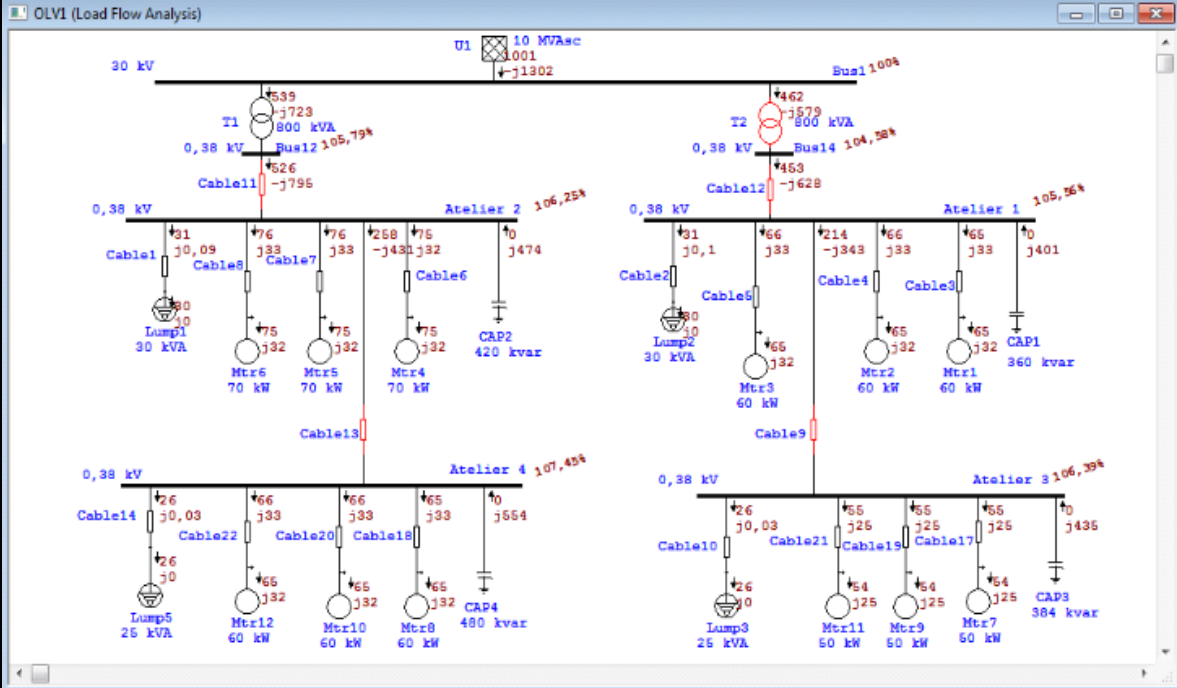
Figure 6: The result of the power flow after inserting the batteries. Source: Authors, (2020).